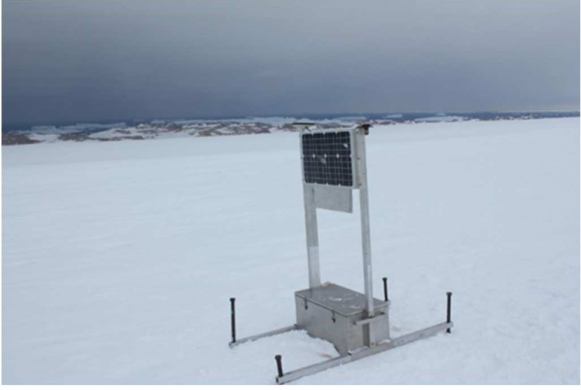
Figure 9. The installation site in